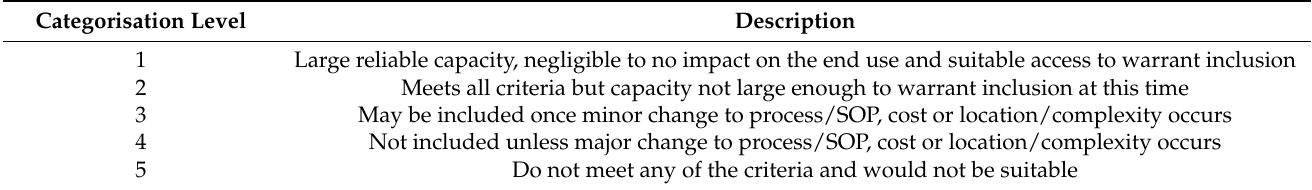
Table 2. Description of asset categorisation levels for step 3 of the